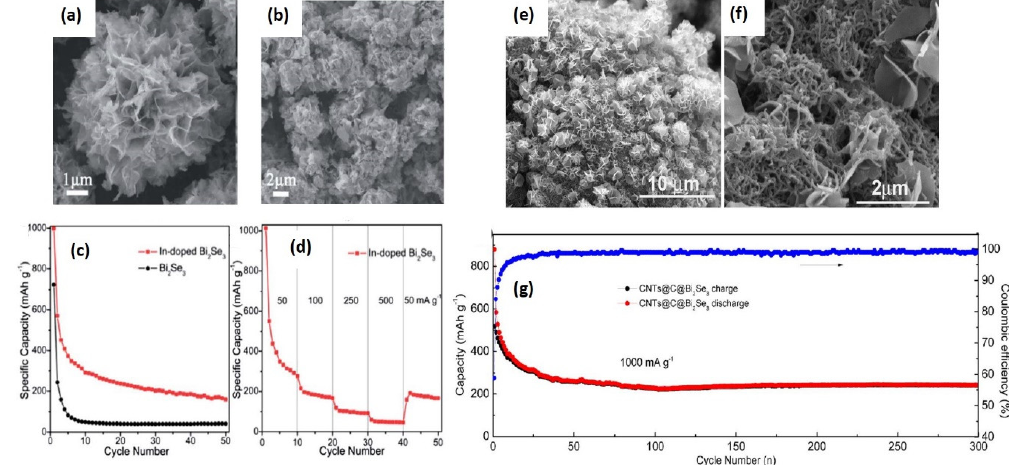
Figure 6. ( a ) Scanning electron microscopy (SEM) image of In-doped Bi 2 Se 3 nanostructures, ( b ) SEM image of undoped Bi 2 Se 3 nanostructures, ( c ) cycling performance of doped and undoped Bi 2 Se 3 ; ( d ) cycling performance at different current rates, images are reproduced with permission [73], Copyright (2014), Royal Society of Chemistry. ( e ) and ( f ) SEM images of CNTs/C/Bi 2 Se 3 nanocomposites; ( g ) cycling performance of CNTs/C/Bi 2 Se 3 composites. Reproduced with permission [77], Copyright (2017), Elsevier.